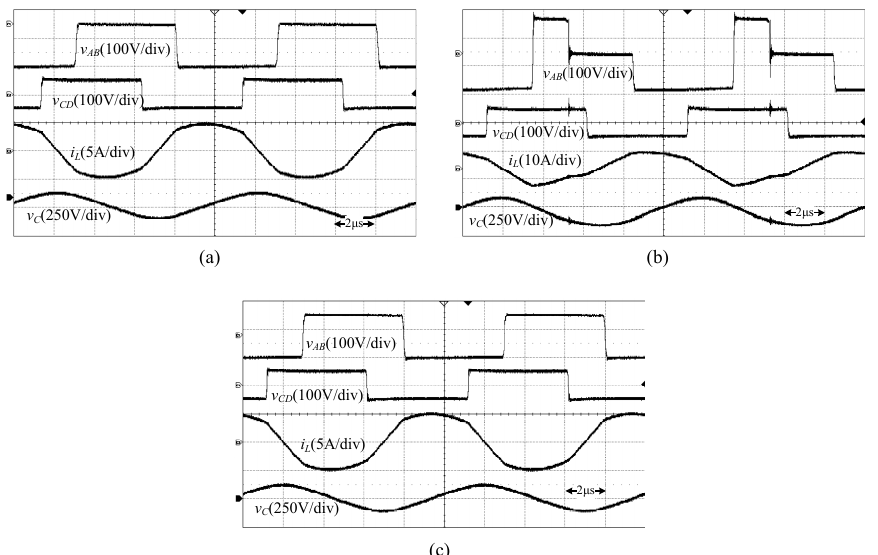
Figure 17. Experimental waveforms of different M when P o = − 200 W: ( a ) M = 0.5, ( b ) M = 0.6, ( c ) M = 1.